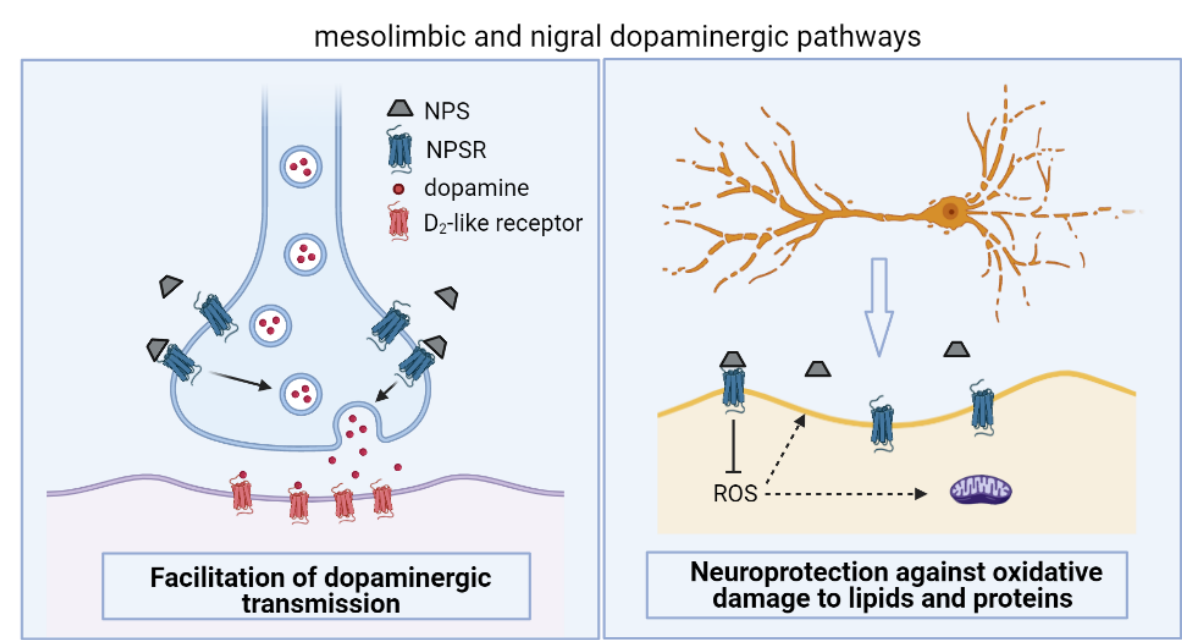
Figure 2. Putative mechanisms by which Neuropeptide S (NPS), activating Neuropeptide S receptor (NPSR), alleviates Parkinson Disease (PD)-induced motor and non-motor dysfunctions. NPS increases dopaminergic transmission in mesolimbic and nigral dopaminergic pathways by facilitating the dopamine transmission ( left panel ). NPS promotes neuroprotective effects on dopaminergic neurons possibly by counteracting reactive oxidative species (ROS)-induced damage to structural lipids and proteins ( right panel ).